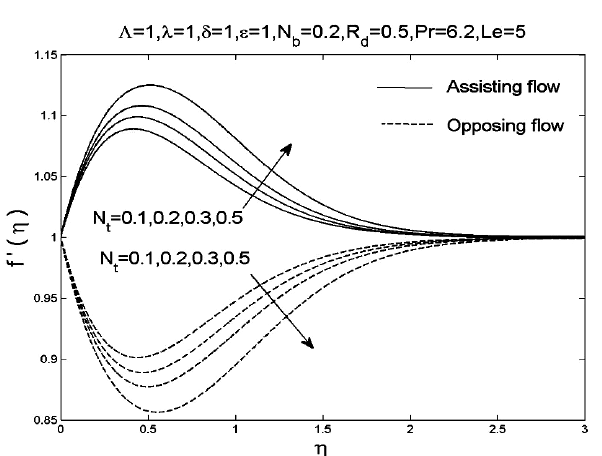
Fig. 6. The effect of the thermophoresis parameter Nt on the ve- locity profiles ( ) f η′ .